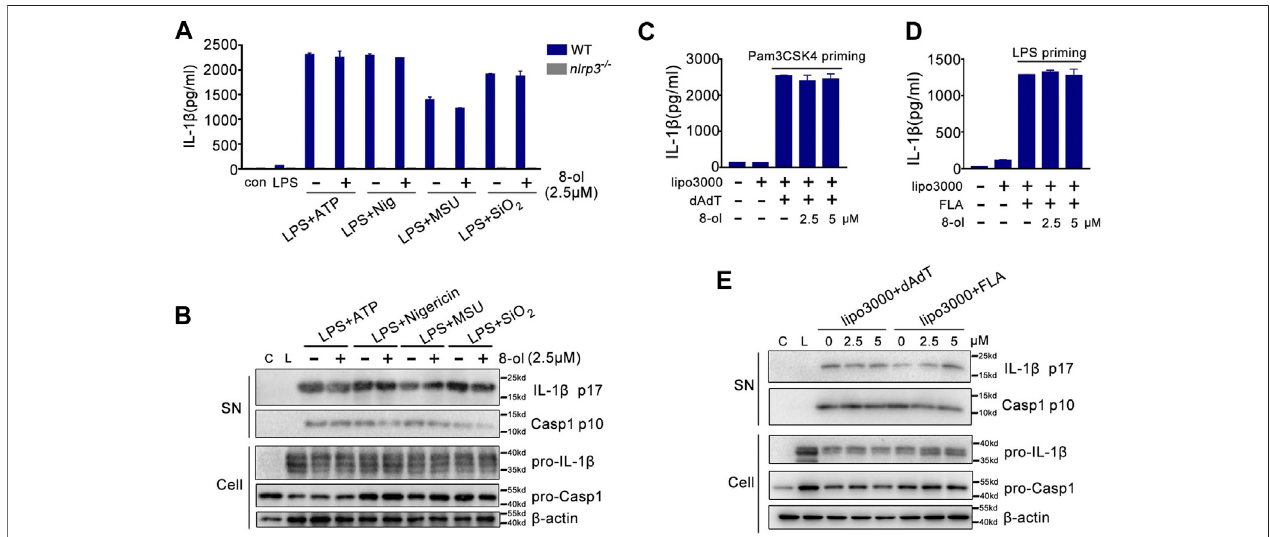
FIGURE2| 8-oldoesnotaffecttheactivationofNLRP3,AIM2,andNLRC4in fl ammasomes. (A – B) ELISAforIL-1 β andWesternblotsforthecleavageofIL-1 β and caspase-1 or the expression of IL-1 β and caspase-1 from WT or nlrp3 − / − LPS-primed (100 ng/ml) peritoneal macrophages stimulated with ATP, nigericin (Nig), monosodiumuratecrystals(MSU),and siliconcrystals(SiO 2 )inthepresenceor absenceof8-ol(2.5 μ M). (C – E) ELISAforIL-1 β andWesternblotsforthecleavageofIL- 1 β and caspase-1 in the supernatant or the expression of IL-1 β and caspase-1 in the cell lysates from Pam3CSK4 (1 μ g/ml) or LPS (0.1 μ g/ml)-primed peritoneal macrophages which are then transfected with 1 μ g/ml poly (dA:dT) or 2 μ g/ml fl agellin by Lipofectamine 3000 in the presence or absence of 8-ol. Graphs show the mean ± SD of technical replicates and are representative of at least three independent